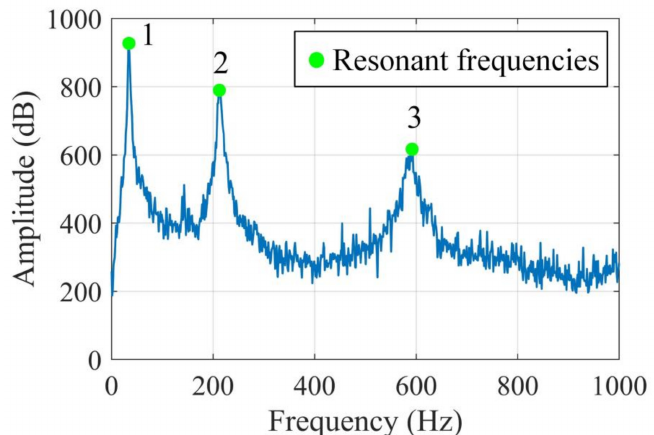
Figure 2. System natural frequency indicator based on the singular value decomposition (SVD) of the PSDT method.